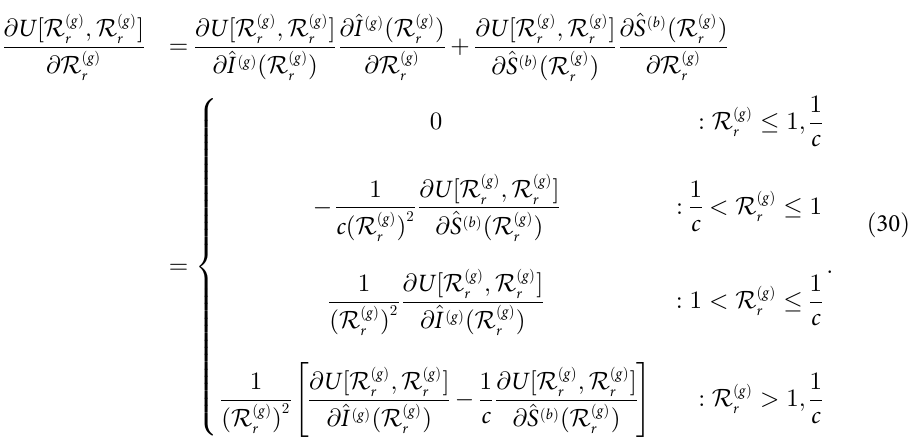
Fig 5. Illustration of the four possible qualitative behaviors for R ð g Þ infectiousness for the bad contagion c and relative weight placed on the good contagion α under Cobb-Douglas utility. The various regions are defined by the relative size of R ð g Þ ¼ 1 or R ð g Þ > 1 , with the boundaries between regions as characterized by Table and whether R ð g Þ opt opt c c